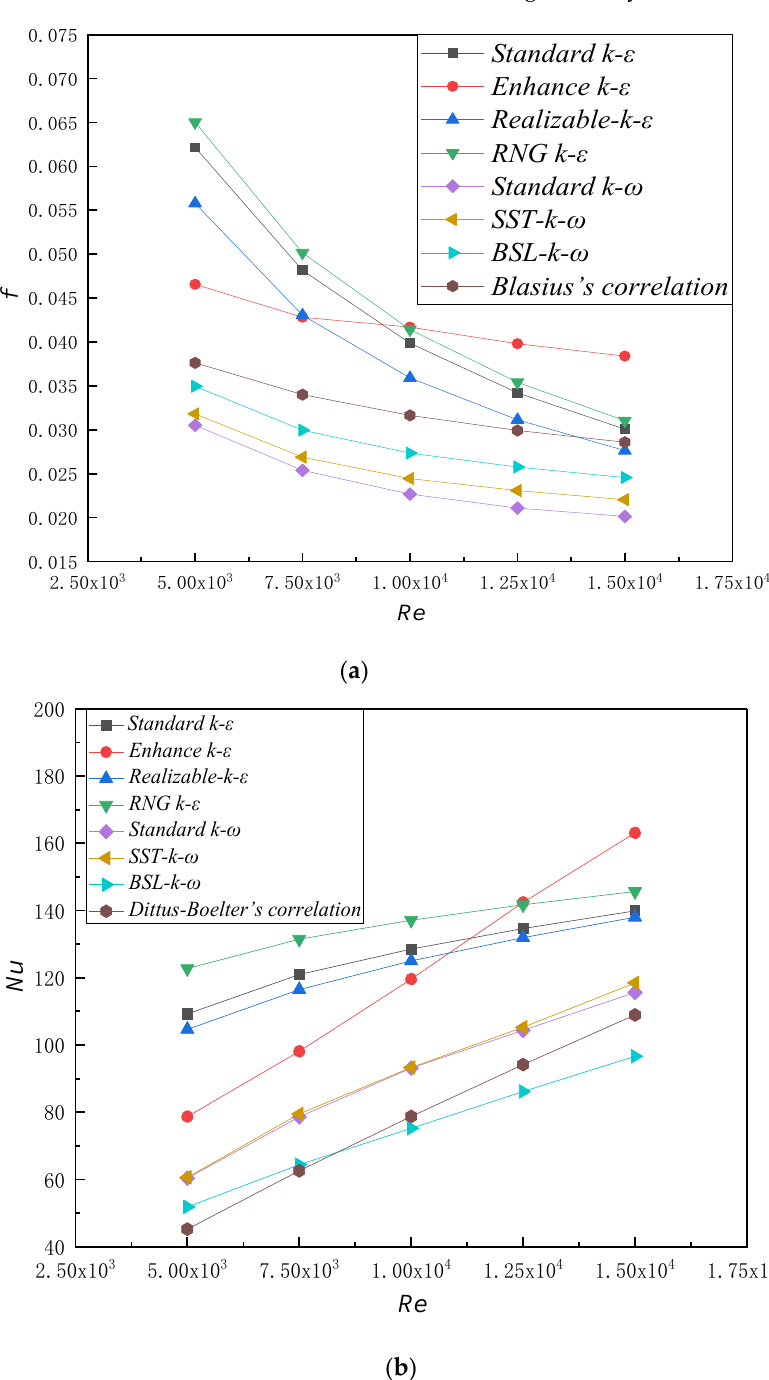
Figure 2. Verifications between numerical results and correlation data: ( a ) Verifications of f ; ( b ) Verifications of Nu .